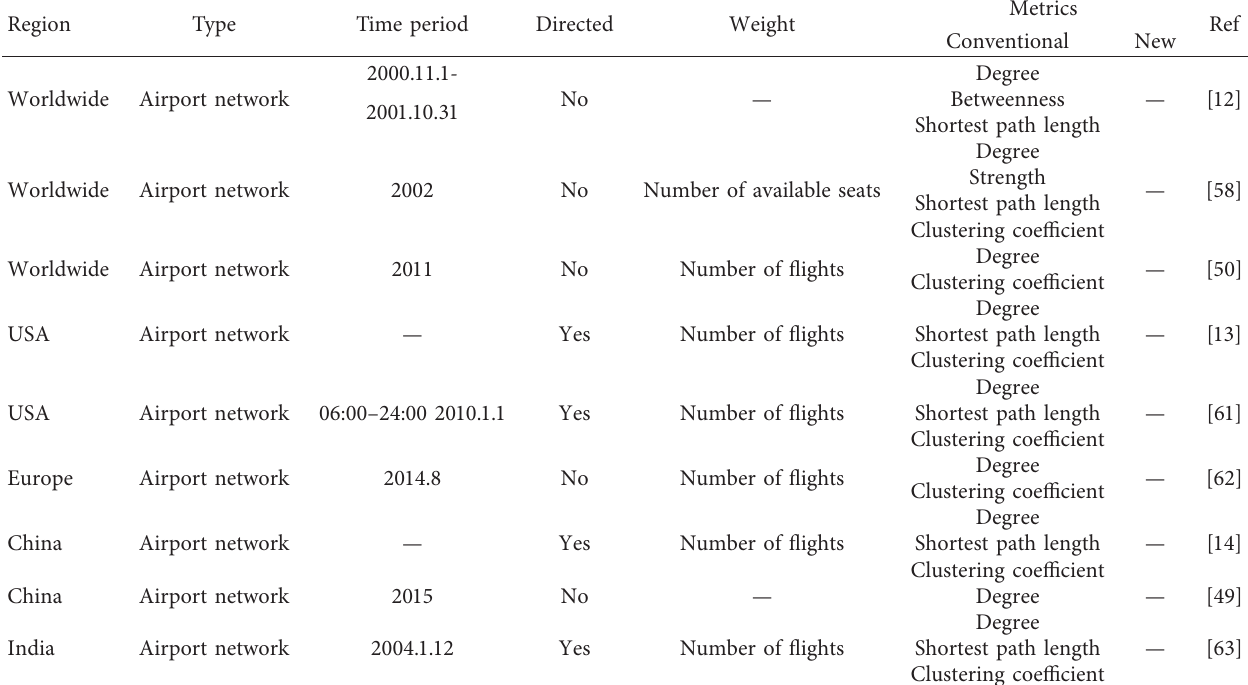
Table 2: Some strong impact analyses on static air transport networks.